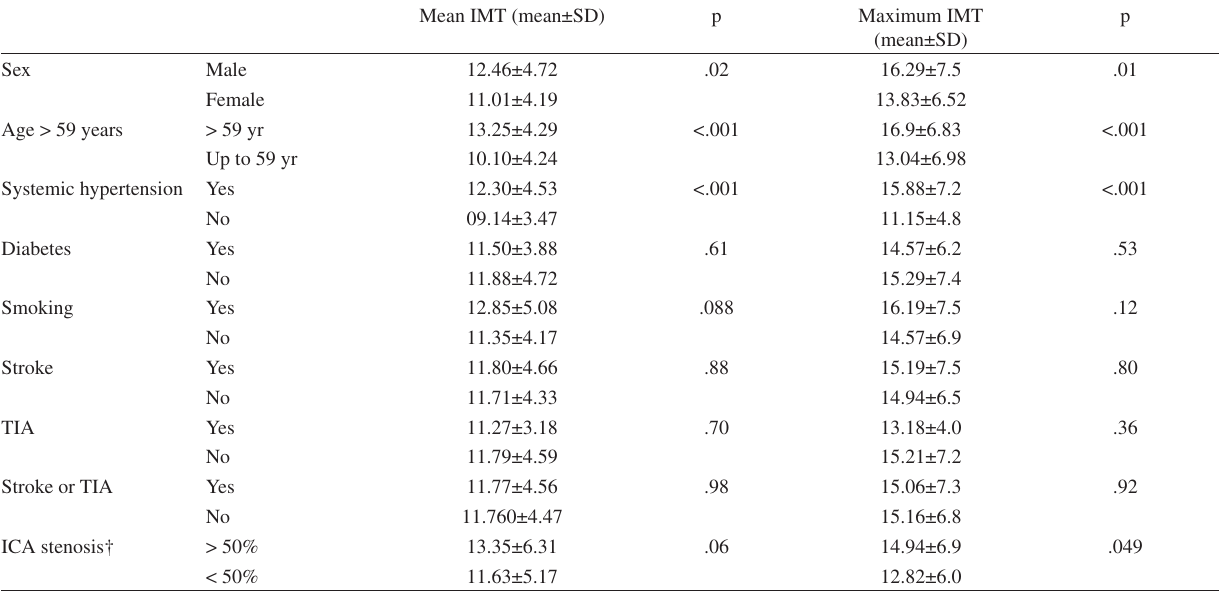
Table III - Risk factors associated with increased IMT*